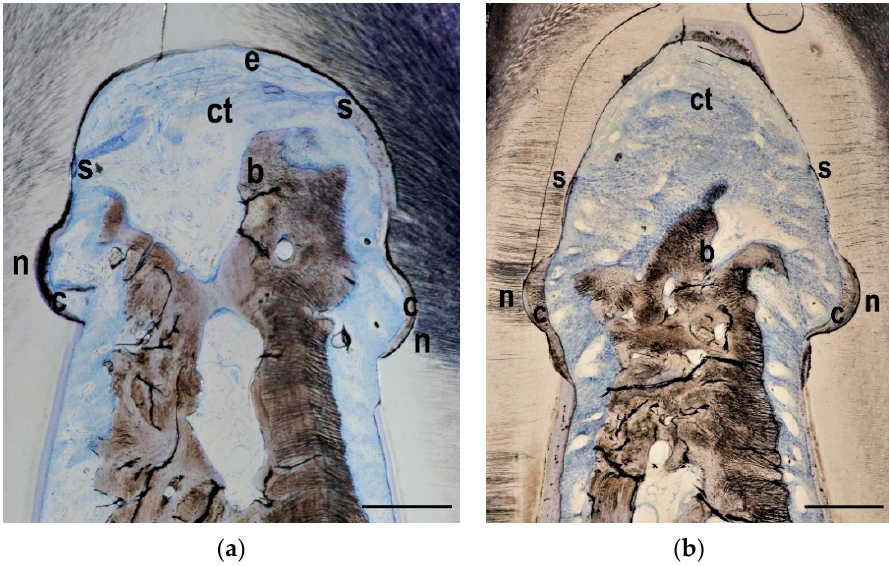
Figure 4. GTR group histology from the keyhole ( a ) and the horizontal ( b ) defect types. Whereas the notches (n) on both sides of the defect have still been covered with a layer of new cementum (c), the cement formation has stopped (s) coronal to the notches and has not covered the whole furcation roof. Some new bone ( b ) has grown into the furcation area and occupied approximately half of the defect height. Connective tissue (ct) and epithelium (e) have formed in the coronal part of the furcation. Bar in lower right corner represents 0.5 mm.